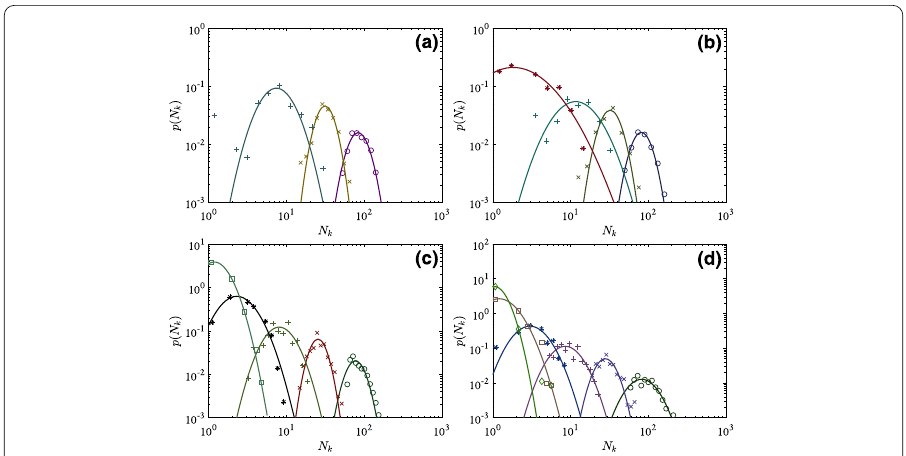
Figure 6 Probability distribution of the number of alters in different layers for the SVEIN. The solid curves represent the best log-normal fits to the empirical distribution. ( a ) Egos with three layers obtained from the k -means algorithm. ( b ) Egos with four layers obtained from the k -means algorithm. ( c ) Egos with five layers obtained from the H / T break algorithm. ( d ) Egos with six layers obtained from the H / T break